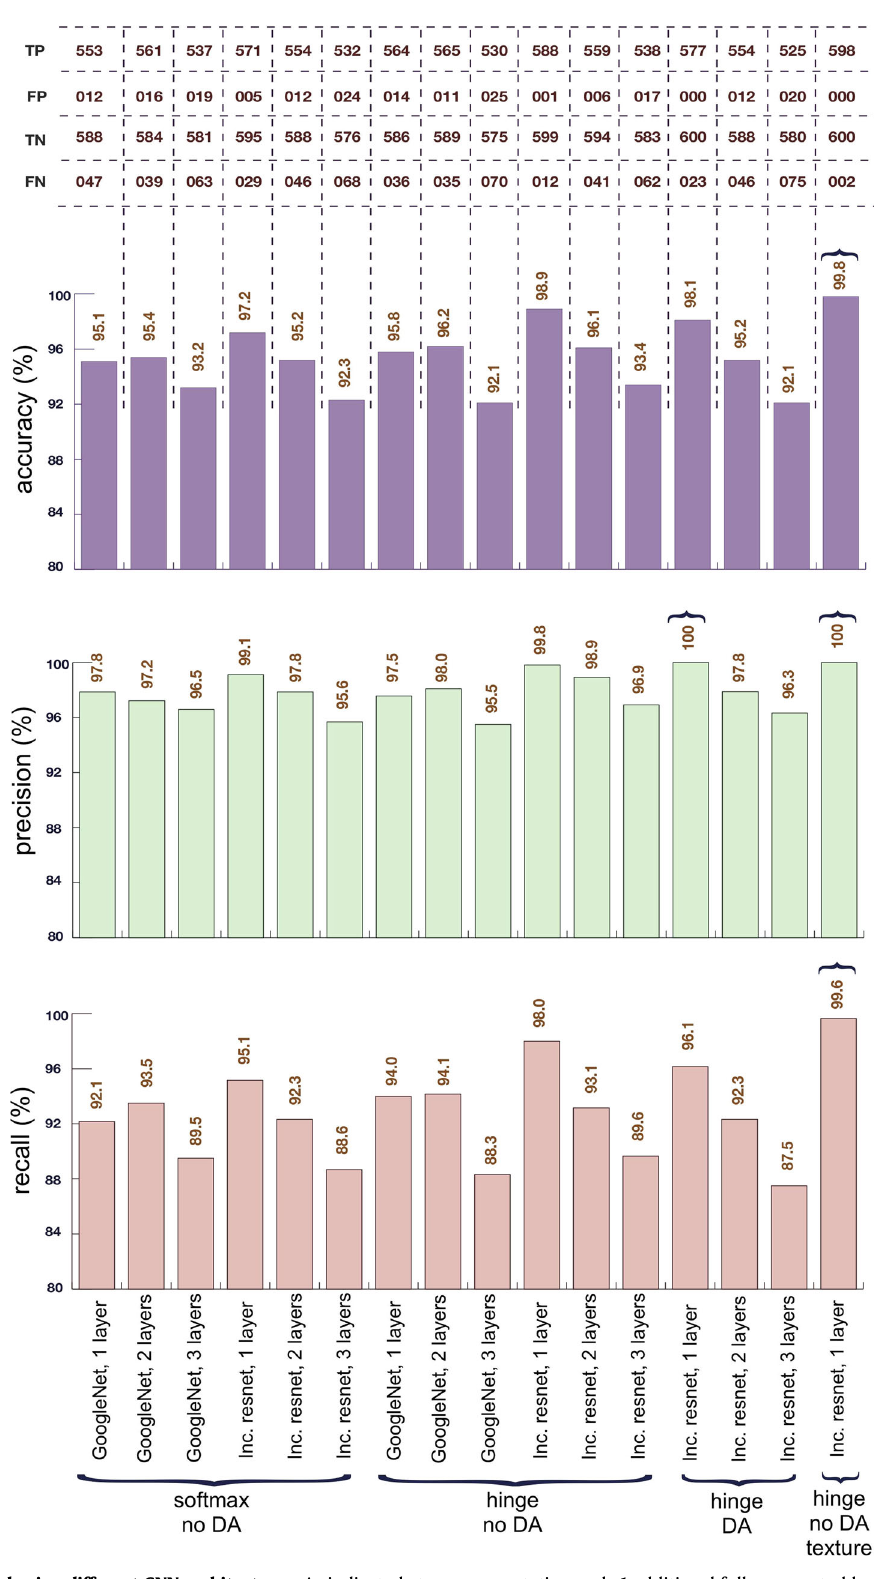
augmentation, only 1 additional fully connected layer for transfer learning, hinge loss, and fusion of texture recognition (rightmost column). All results are averaged over the random splits we created as a part of our dataset (TP=true positives, TN=true negatives, FP=false positives, FN=false negatives; recall= [TP/(TP+FN)], precision=[TP/(TP+FP)], accuracy=[(TP+TN)/ (TP+TN+FP+FN)]).